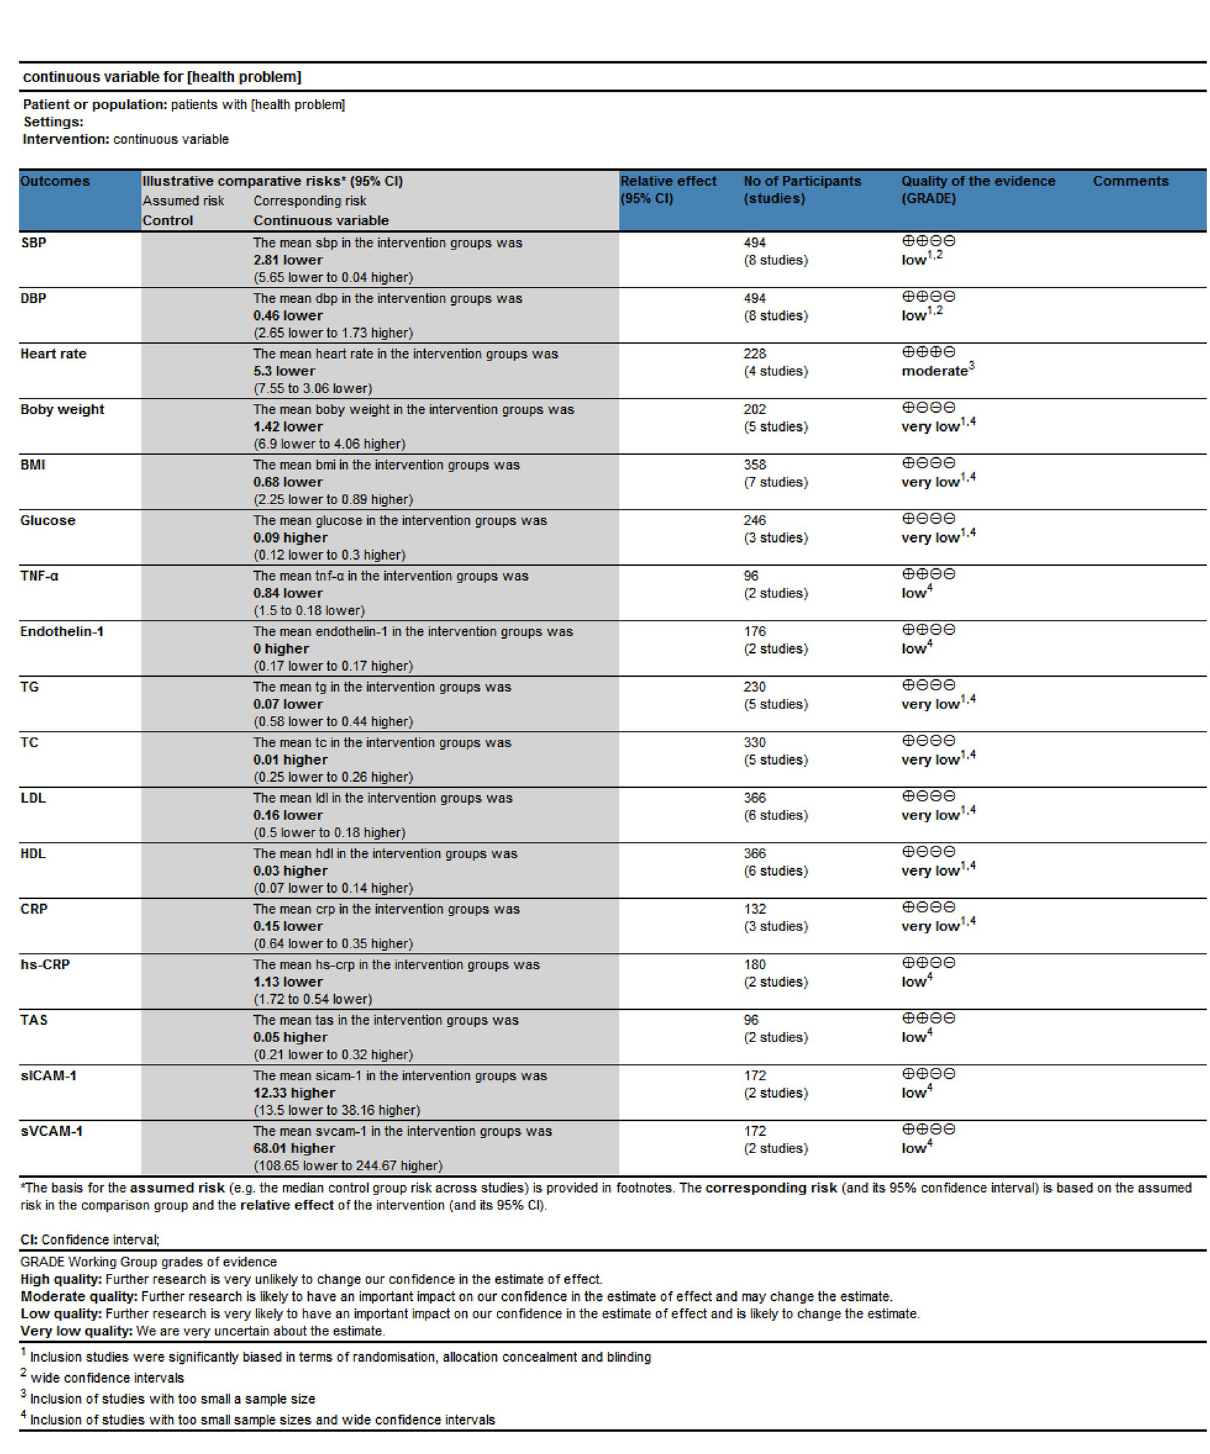
Fig 10. GRADE levels of evidence.